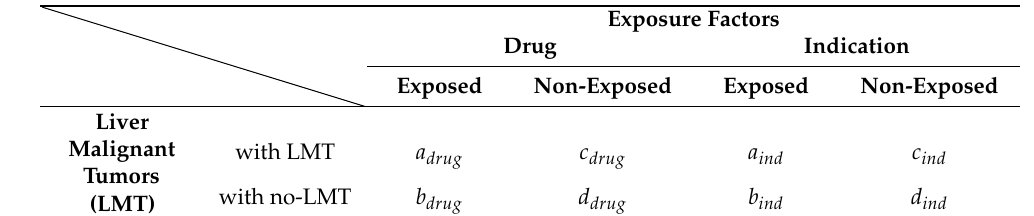
Table 2. Contingency table for calculating reporting odds ratios. a , number of LMT reports in exposed group; b , number of no-LMT reports in exposed group; c , number of LMT reports in non-exposed group; d , number of no-LMT reports in non-exposed group. The subscript “drug” means that the exposure factor is drug use. The subscript “ind” means that the exposure factor is indication